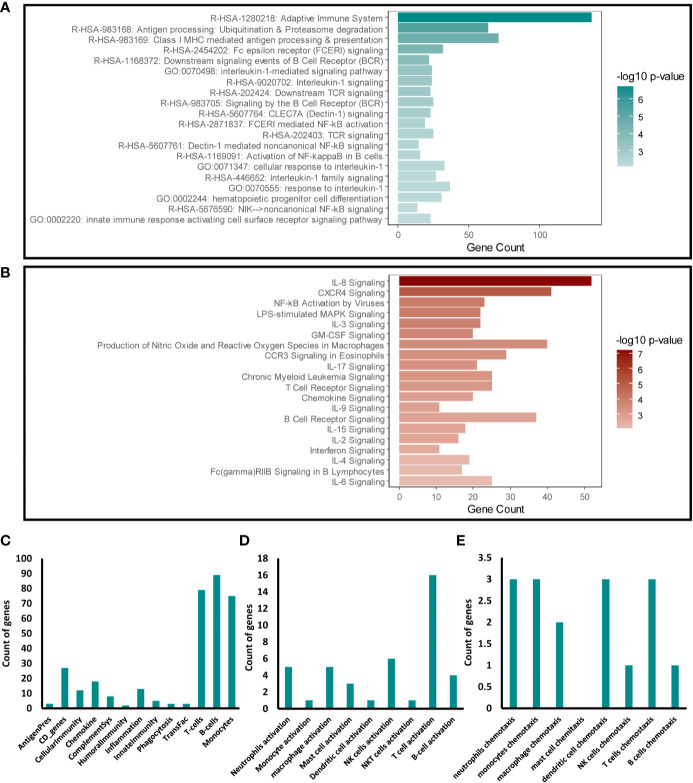
Immunomodulatory effect of Snail-p53 binding inhibition. Enriched representation of the top 20 immune response pathways and functional clusters identified in analysis conducted using (A) Metascape and (B) IPA. The count of intersecting genes from the GN25 treated cells with the (C) Immunome set (D), immune cells activation gene ontology sets, and (E) immune cells chemotaxis gene ontology sets.